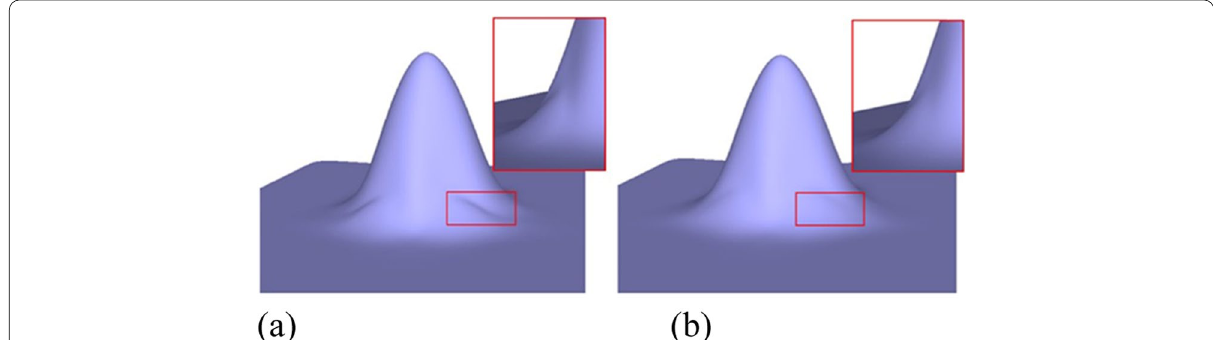
Fig. 1 Limit surfaces for a non-uniform EP with a different eigenpolyhedron, using a the eigenpolyhedron in ref. [7] and b the proposed approach